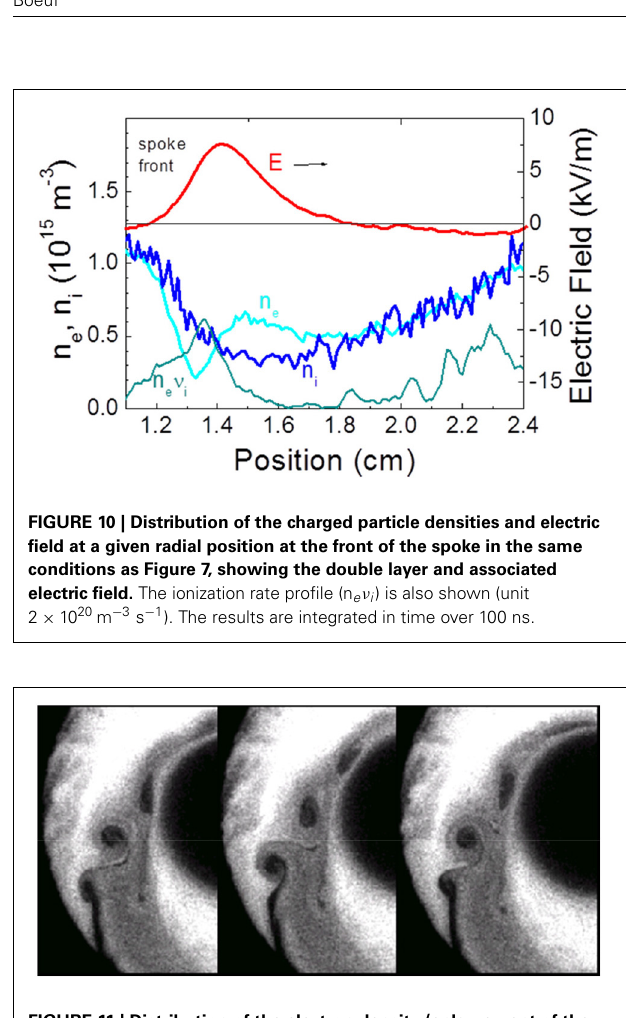
FIGURE 11 | Distribution of the electron density (enlargement of the front region) at three successive times separated by 20ns showing the two-stream instability in the spoke front. Darker regions correspond to lower electron densities (same conditions as Figure 7